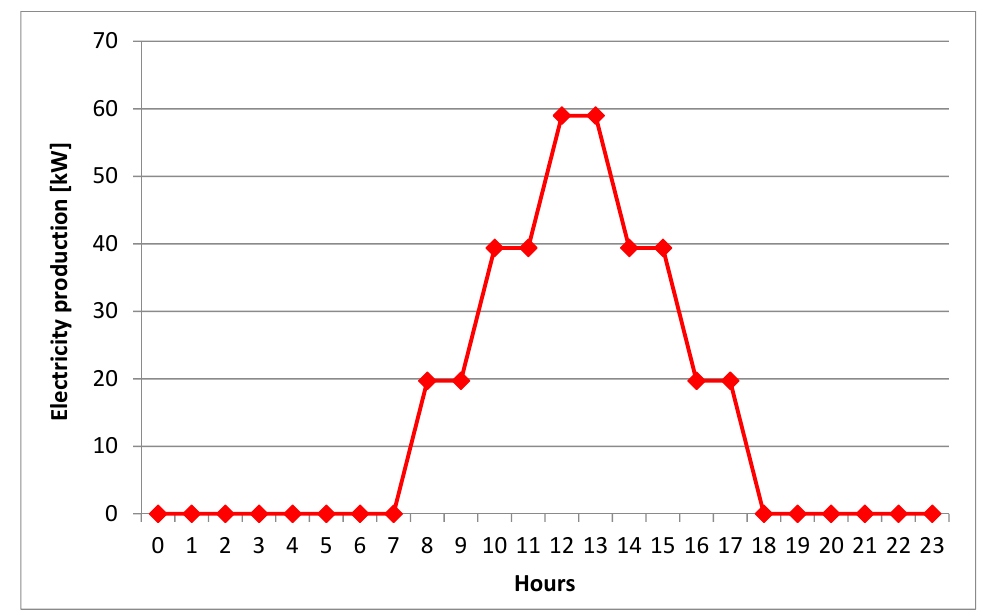
Figure 6. An electricity demand profile for an agent.